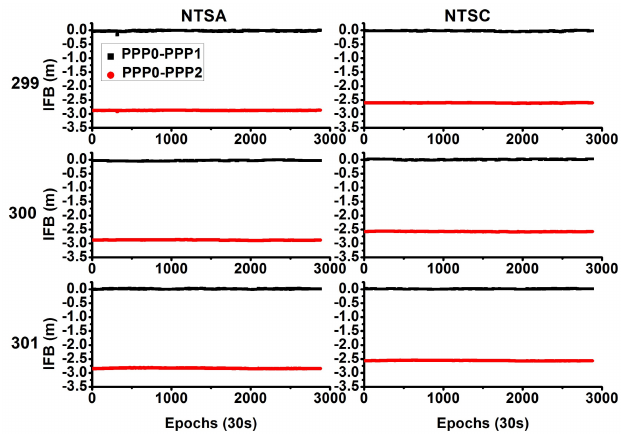
Figure 4. Comparison of inter frequency bias between different solution models ( left side represents NTSA station, and right side represents NTSC